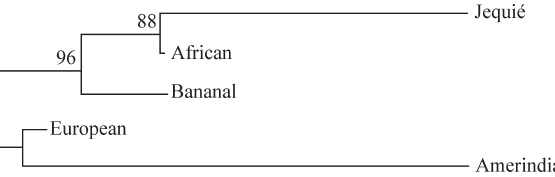
Figure 1 - Dendrogram generated by the neighbor joining method from Nei’s genetic distances between the ancestral African, European and Am- erindian populations and the Bananal and Jequié